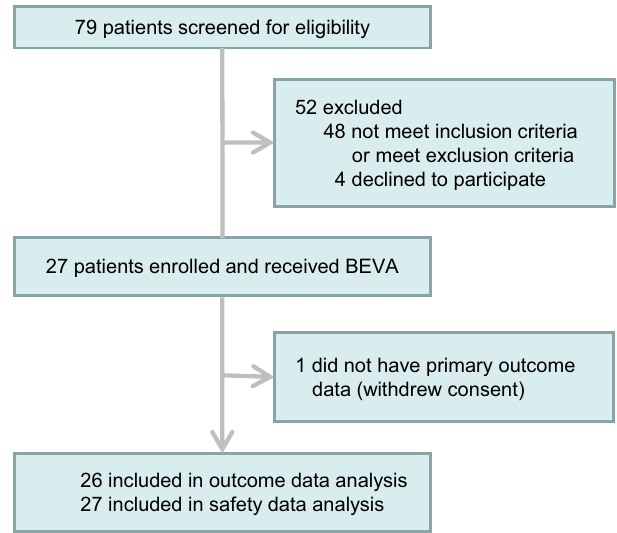
Fig. 1 CONSORT fl ow diagram. Twenty-seven participants were